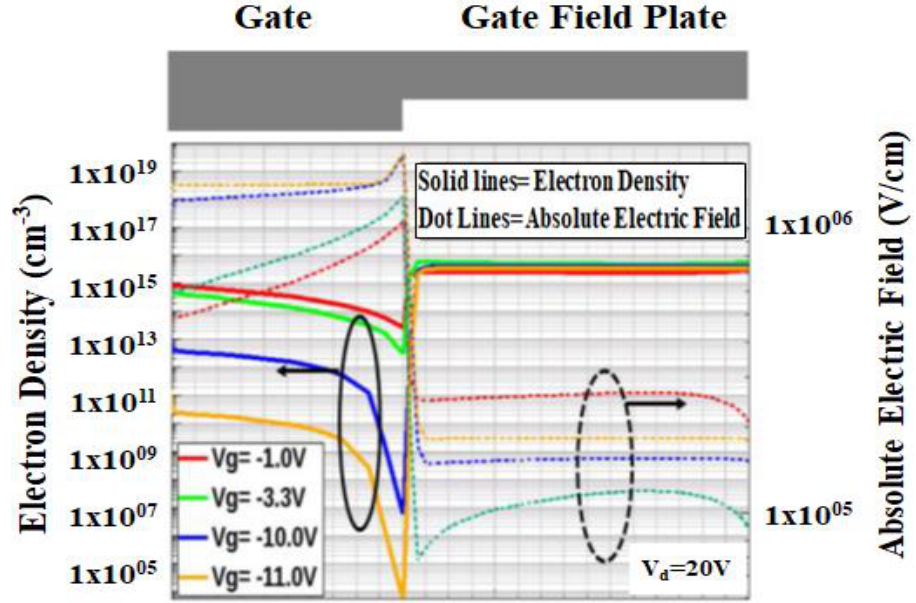
Figure 12. Simulation of electron density and absolute vertical electric field distribution in GaN HEMT